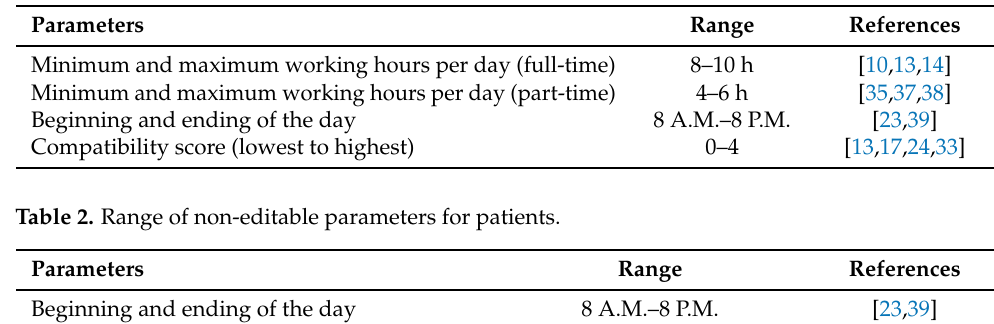
Table 1. Range of non-editable parameters for caregivers.